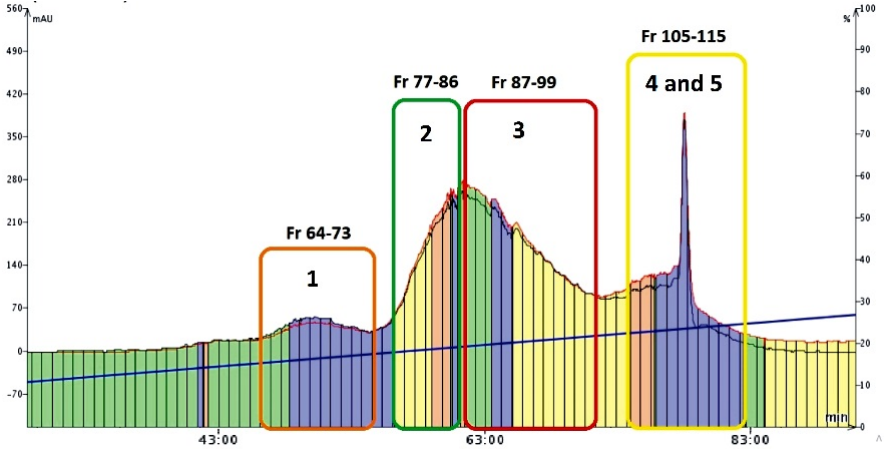
Figure 4. Chromatogram (recorded at 260 nm) showing the main fractions (eluates) with polar isoflavone glycosides (and compound numbers presented below) collected during the FC run.